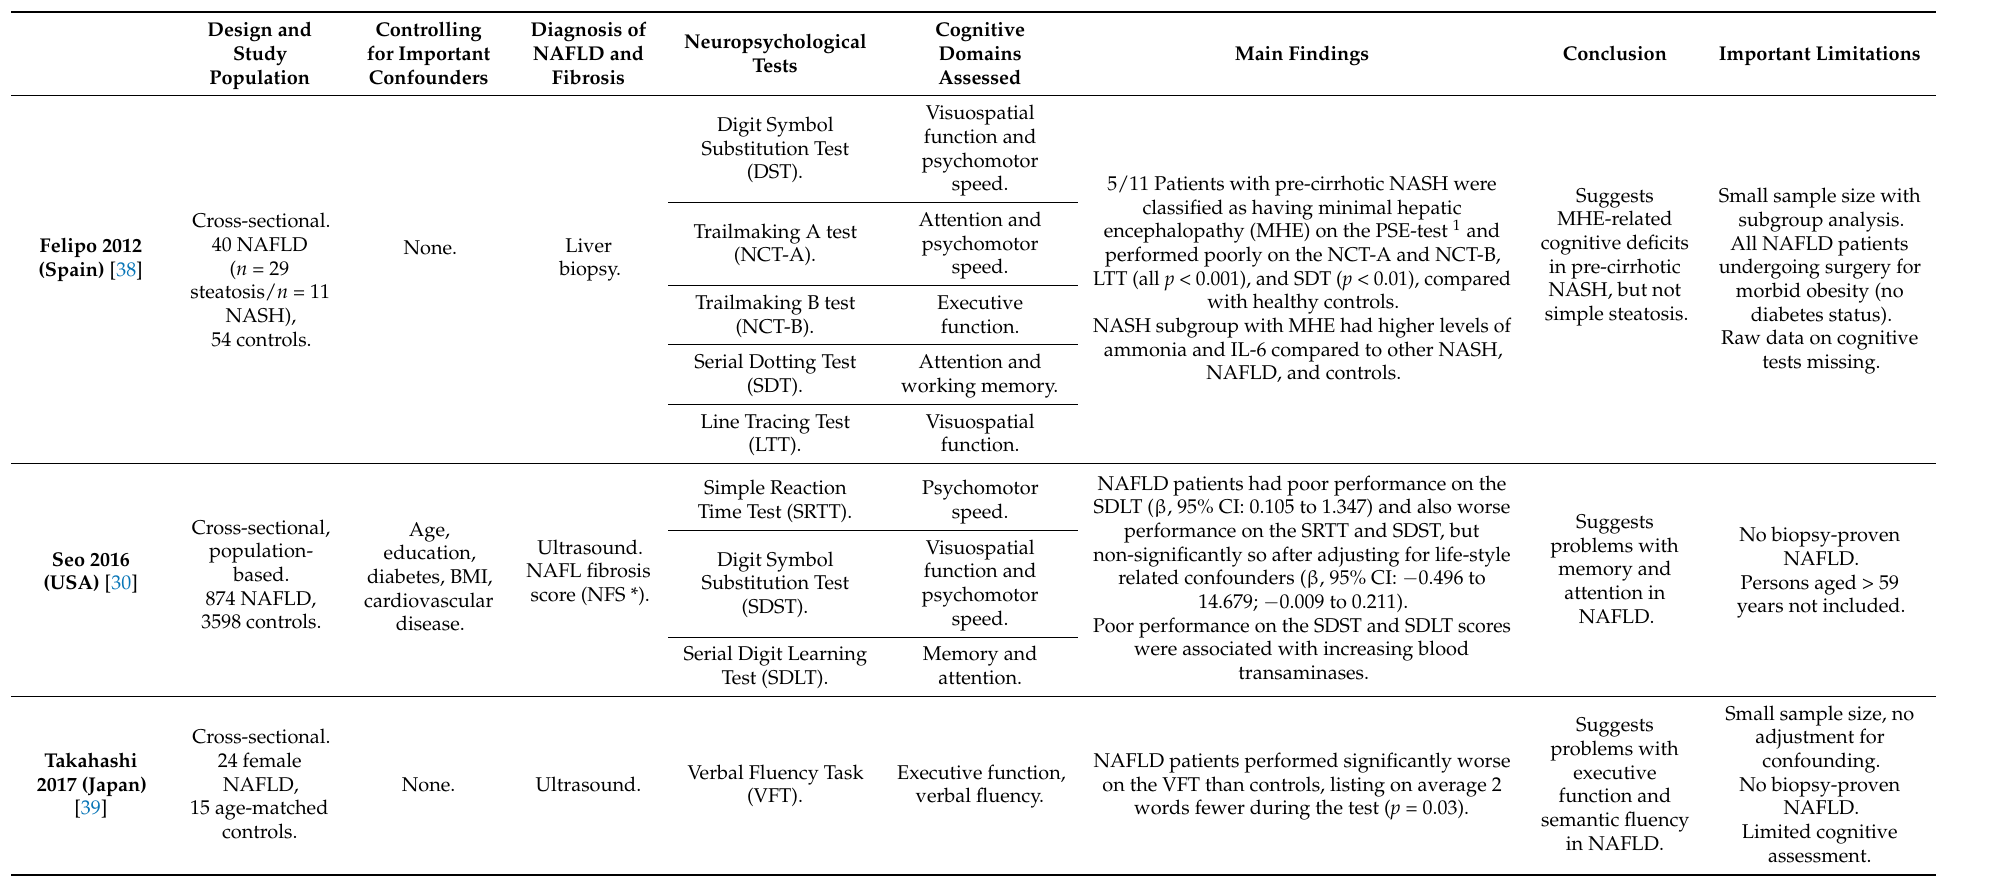
Table 1. Evidence for cognitive dysfunction in non-alcoholic fatty liver